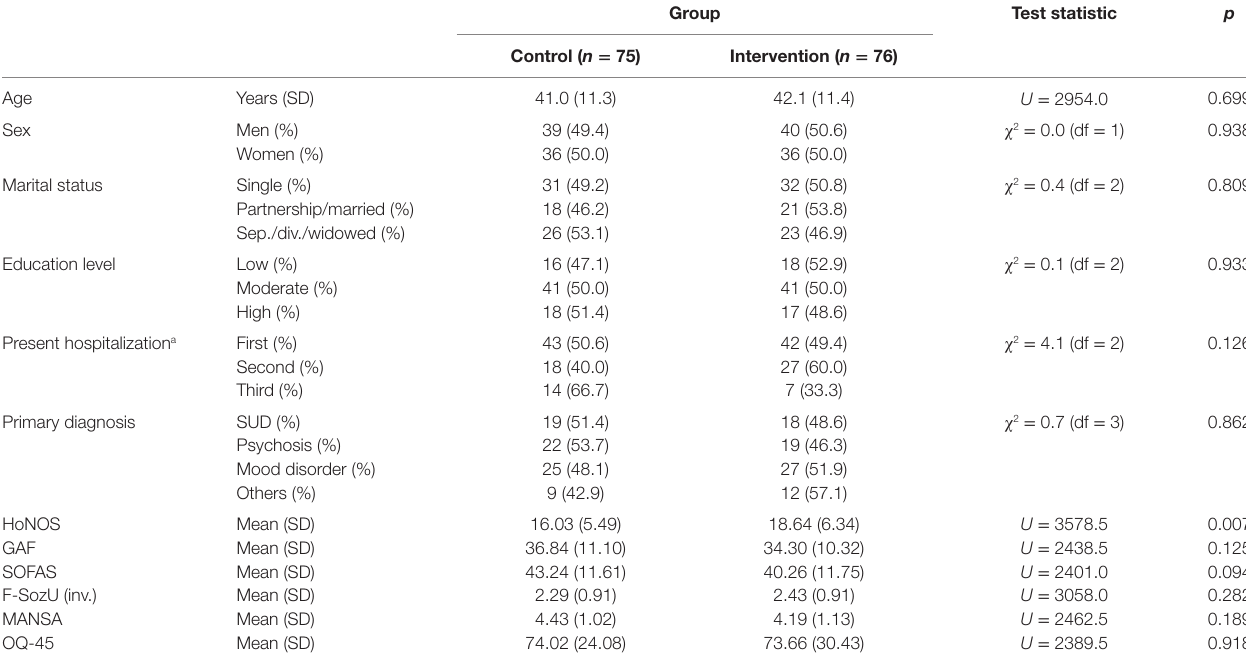
TaBlE 1 | Baseline descriptive statistics ( t 0 ).